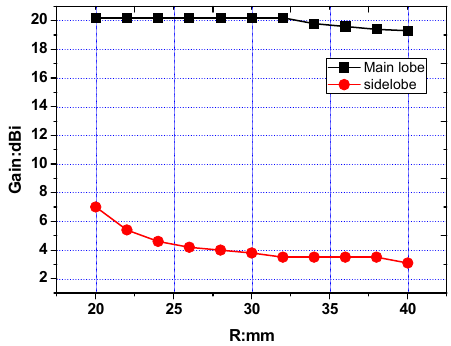
Figure 9. Gain values of the main and sidelobes at different contour radii. at 59 GHz.